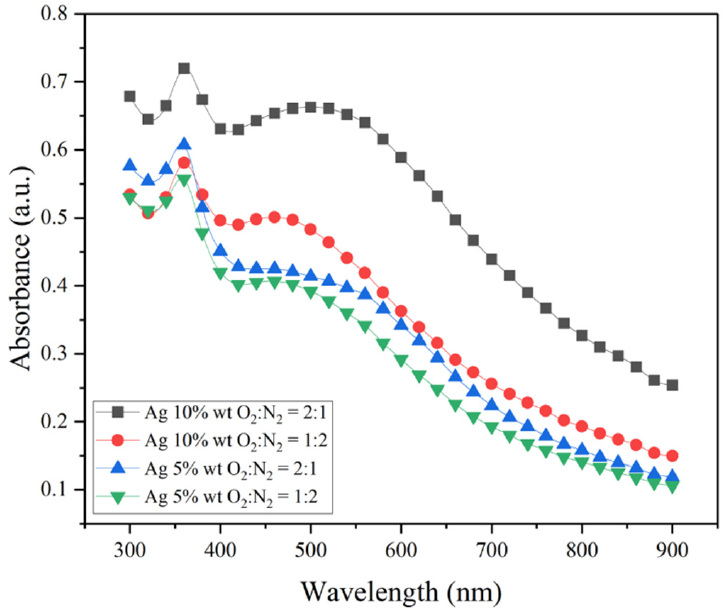
Figure 8. Absorbance spectra of ZnO ‐ Ag nanoparticles with different carrier gas ratios and Ag contents.